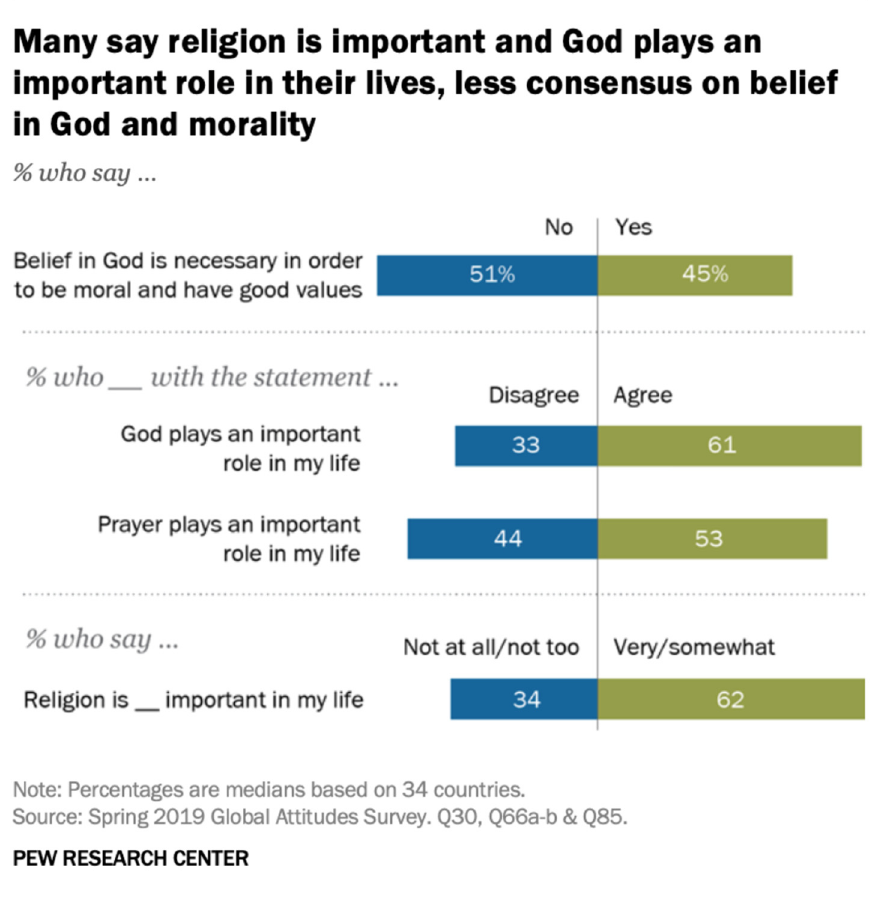
Figure 1. Percentage on how religion and God plays an important role in the life of population. Source: Global Attitudes Survey (Pew Research Center 2019).